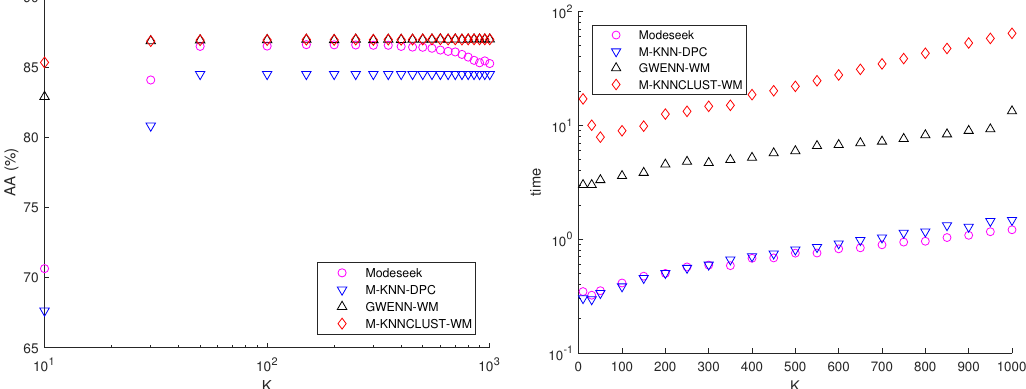
Figure 5. Comparison of the four baseline methods as a function of the number of NNs K on the Worms-2D dataset. Left: Number of found clusters C (true number of clusters in dotted line); right: average accuracy.